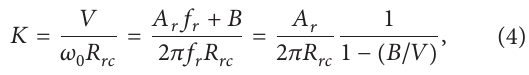
the cup center averaged in one complete rotation, 𝜔 0 𝑅